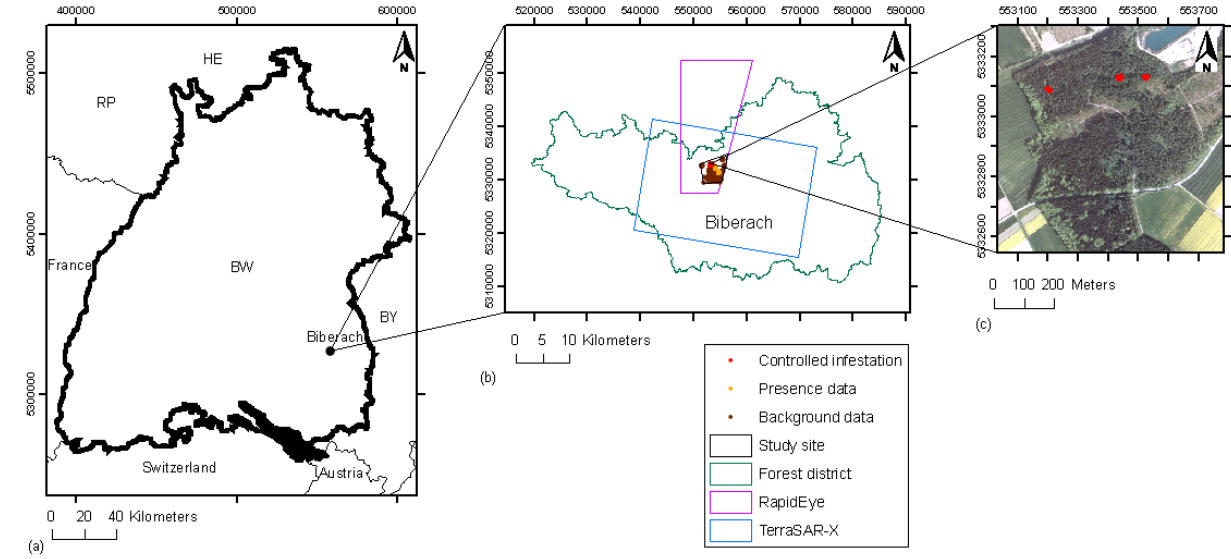
Figure 1. ( a ) Location of the study site Biberach with the surrounding countries and German federal states (BW = Baden-Württemberg, BY = Bavaria, HE = Hesse, RP = Rhineland-Palatinate) (UTM coordinates zone 32N in the margins). ( b ) Forest district with the location of the satellite images and reference data. ( c ) Location of the tree groups with pheromone dispensers (orthophotograph in the